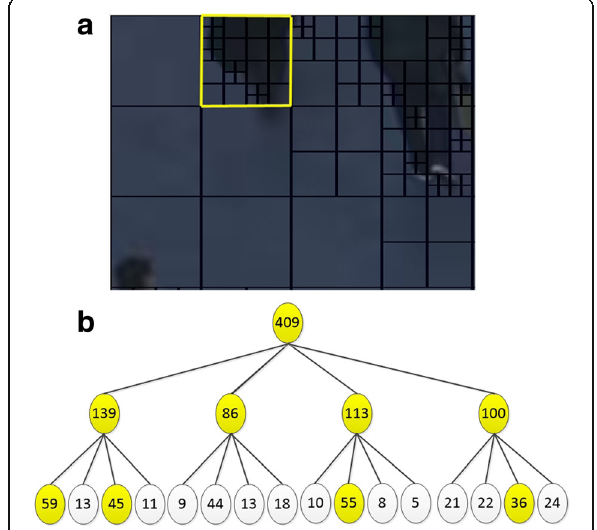
Fig. 8 An example of part of PeopleOnStreet sequence CU coding bits. a The CU best combinations. b The coding bits of CUs in yellow box in ( a )